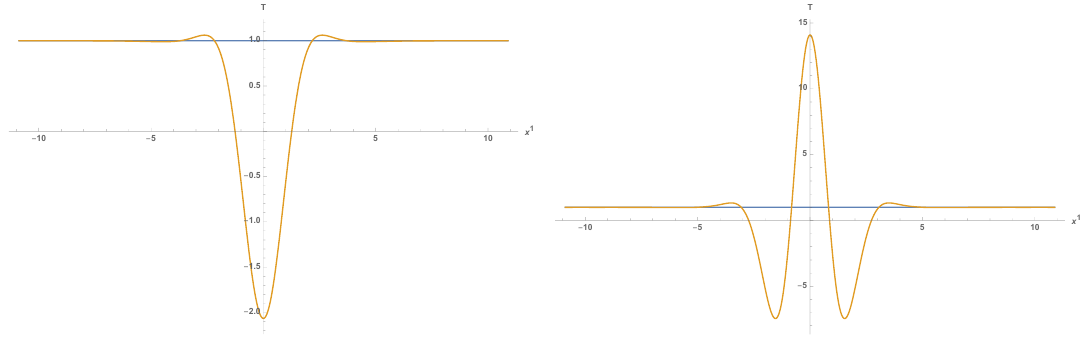
Figure 32 . Tachyon pro(cid:12)les for the lump (left) and excited lump (right) for the ghost number 0 toy model of the solution of